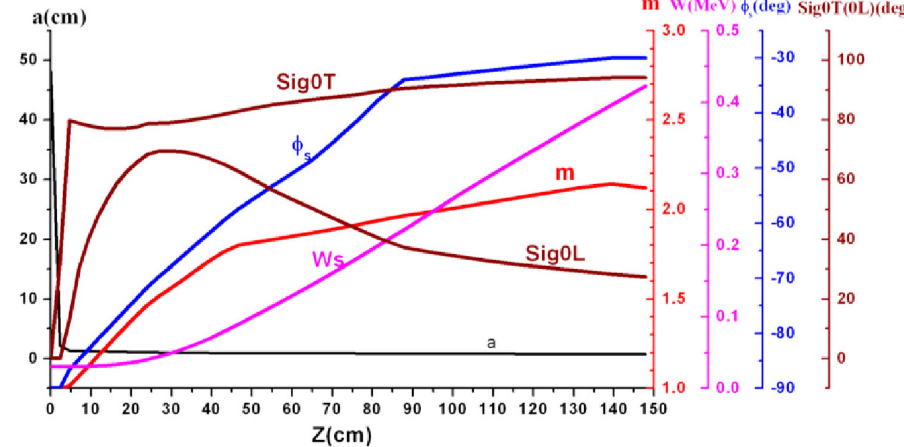
FIG. 9. Main parameters of the RFQ.